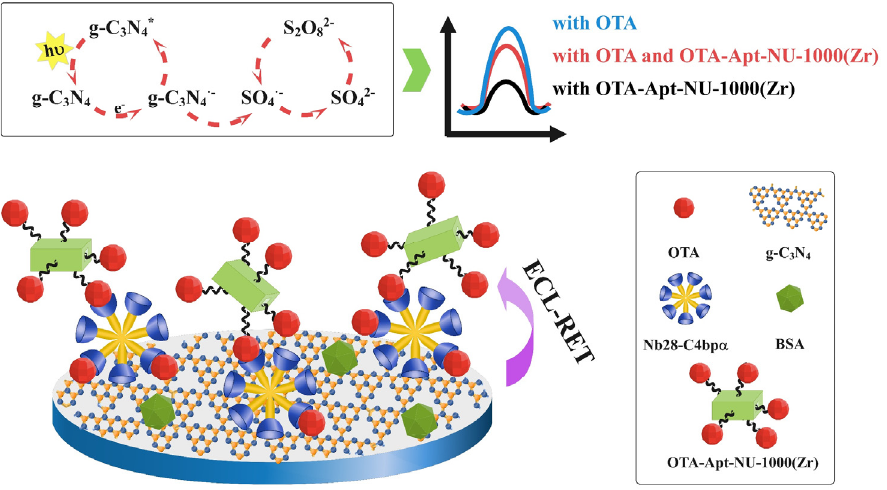
Scheme 1. Schematic diagram of the fabrication process of ECL-RET immunosensor between g-CN and NU-1000(Zr).